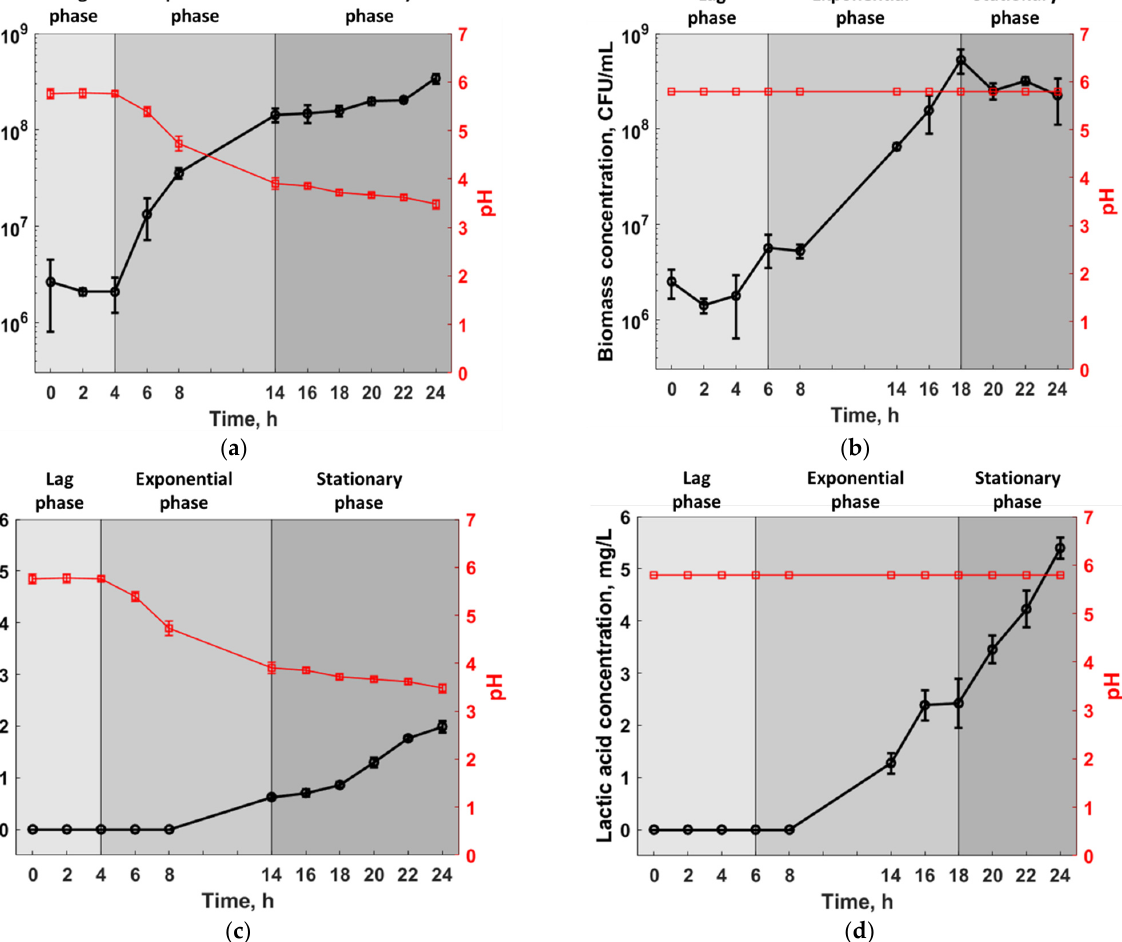
Figure 4. Bacterial growth curves on a semi-logarithmic scale ( a ) without pH control and ( b ) under pH control; lactic acid production during the rice flour fermentation ( c ) without pH control and ( d ) under pH control.